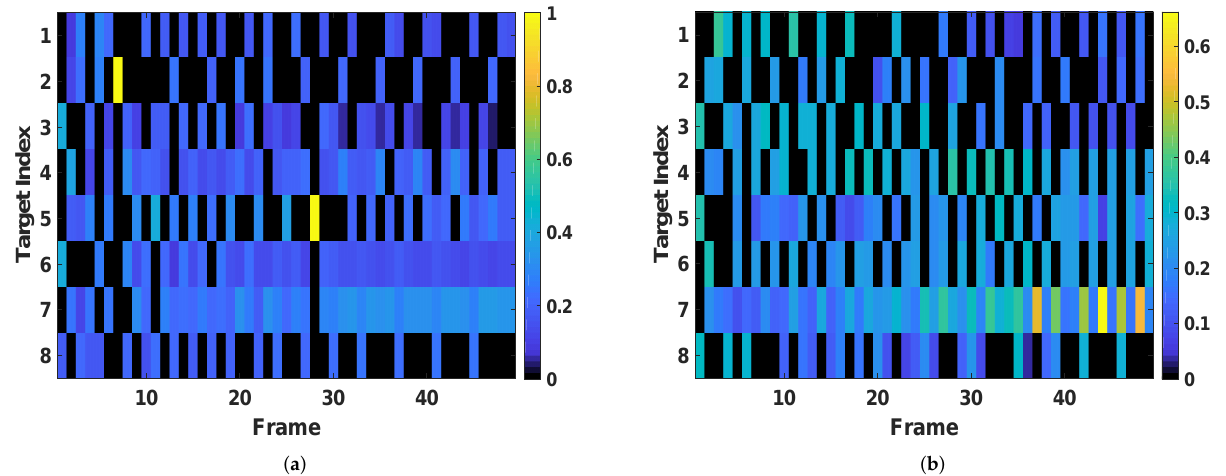
Figure 16. The resource allocation results. ( a ) γ = 0.5 ( b ) γ =